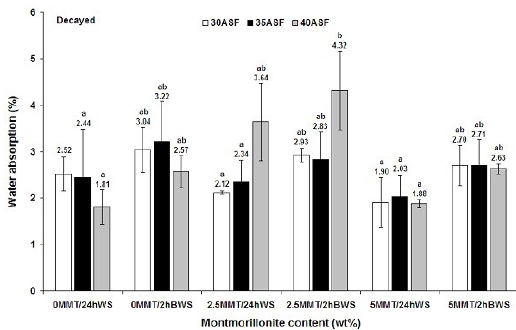
Figure 4. The average and standard error for water absorption measurements (2 h boil water soaked and 24 h water soaked) measurements of the decayed composites).